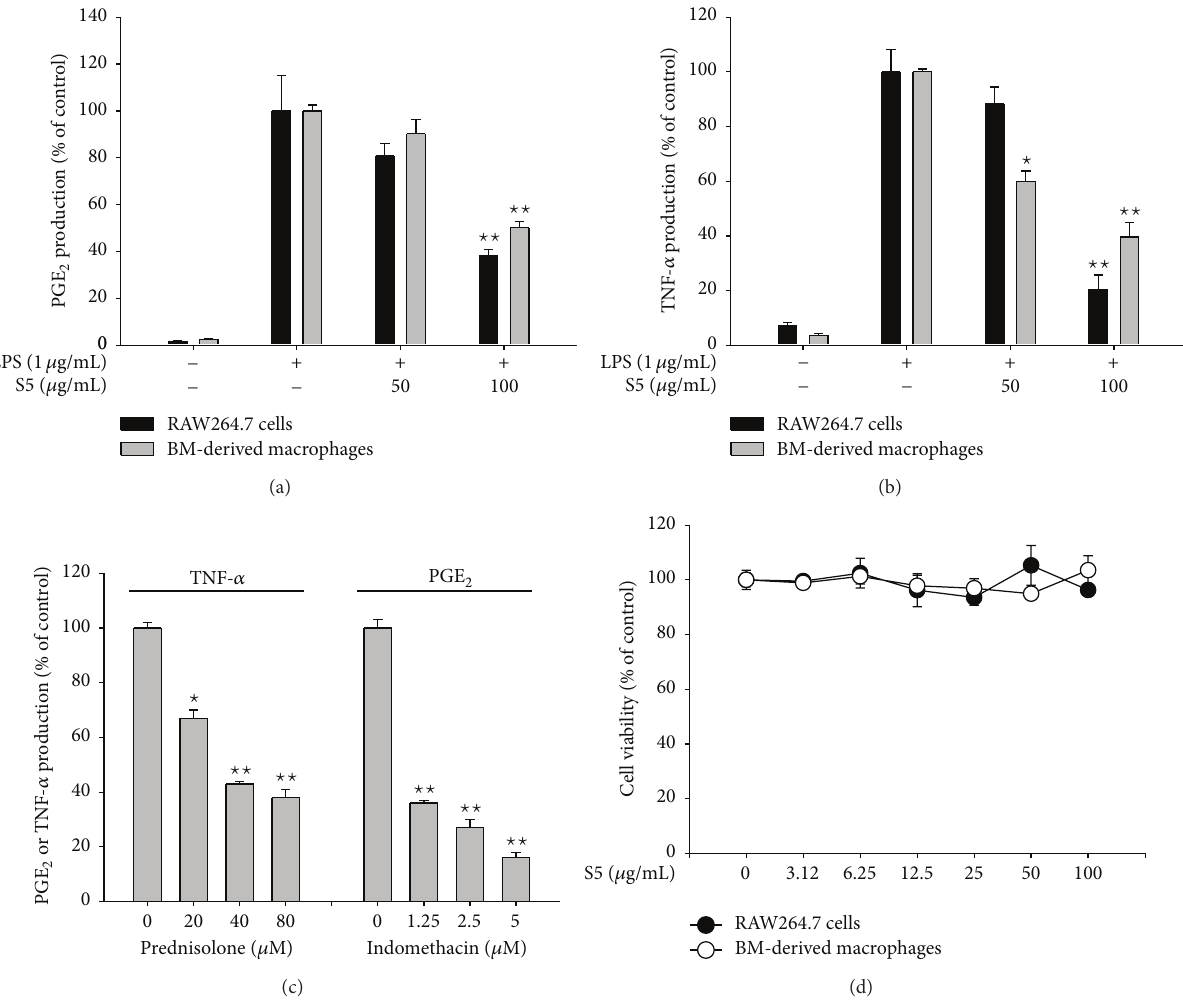
Figure1:EffectsoftheS5peptideonTNF- 𝛼 andPGE 2 productionandviabilityofLPS-treatedRAW264.7cellsandBM-derivedmacrophages. (a, b, and c) The levels of NO, PGE 2 , and TNF- 𝛼 in the supernatants of RAW264.7 cells or bone marrow-derived macrophages that had been treated with the S5 peptide (0 to 100 𝜇 g/mL) or standard compounds (prednisolone and indomethacin) in the presence or absence of LPS (1 𝜇 g/mL) for 6 (TNF- 𝛼 ) or 24 (PGE 2 ) h were analyzed by EIA and ELISA, respectively. (d) The viability of RAW264.7 cells and BW-derived macrophages was determined by the MTT assay. ∗ 𝑃 < 0.05 and ∗∗ 𝑃 < 0.01 compared with control cells; ∗ 𝑃 < 0.05 compared with normal cells.